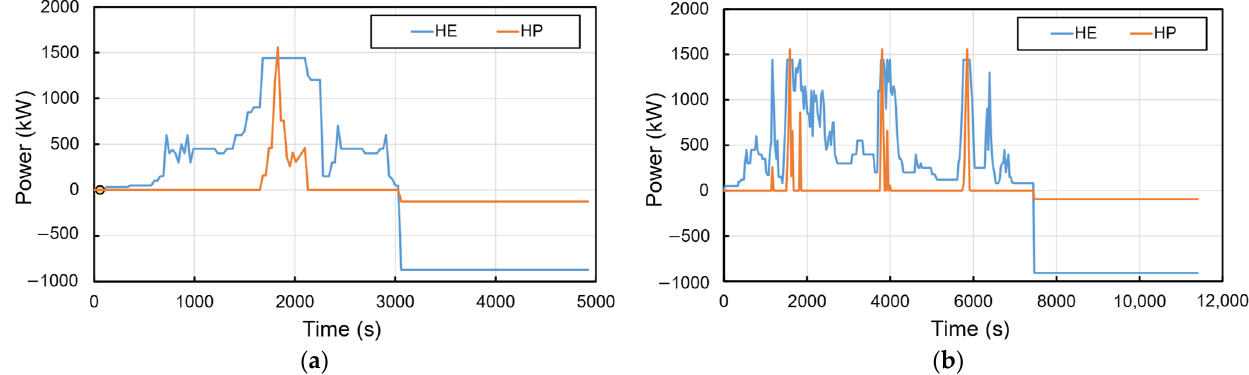
Figure 10. Optimal power split between HE and HP battery packs in HESS: ( a ) primary profile, ( b ) secondary profile.